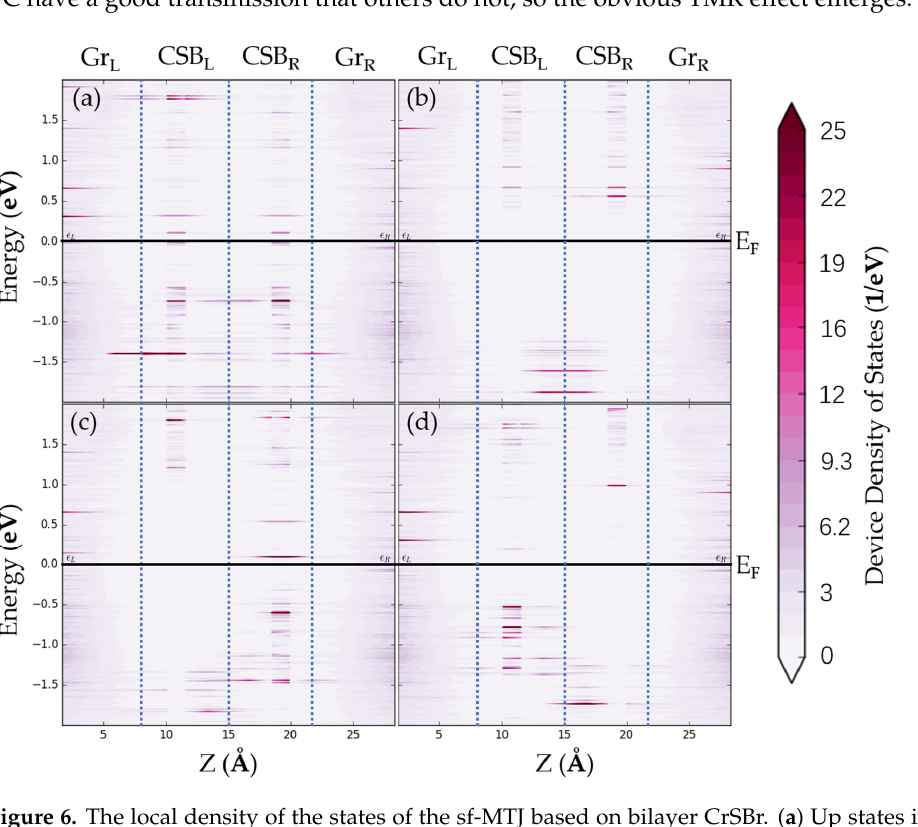
Figure 6. The local density of the states of the sf-MTJ based on bilayer CrSBr. ( a ) Up states in PC; ( b ) Down states in PC; ( c ) Up states in APC; and ( d ) Down states in APC. The vertical axis is the electron energy levels in which the Fermi level is set as 0 eV. The horizontal axis is the position of the device along the transmission direction. Different layers of the device marked above the figure by Gr (cid:2896) (the graphene on the left); CSB (cid:2896) (the left layer of the bilayer CrSBr); CSB (cid:2902) (the right layer of the bilayer CrSBr); and Gr (cid:2902) (the graphene on the left). Red colors indicate a high density of states. The figures are the calculated results of modeling. Subsequently, we will discuss the giant TMR of sf-MTJs with four-layer and six-layer CrSBr. Like the two-layer device, we also obtained the transmission spectra. The trans- mission probabilities of electrons in APC are tiny, leading to negligible (cid:1833) (cid:3002)(cid:3017) . That is one of the factors to the giant TMR values of the two devices (above 10 7 % and 10 5 %). However, the spectra of APC carry little information for the lack of spots with high transmission probability. Therefore, we only provide the transmission spectra of spin-up electrons in PC that have distinct transmission characteristics to illustrate the giant TMRs in Figure 7a,b. Compared with Figure 4a, The transmission characteristics apart from the surround- ing regions of the highest transmission probability in Figure 7a are more indistinctive. To verify the fact that the difference is independent from graphene electrodes, the transmis- sion spectrum of the electrodes is calculated and presented in Figure 7c. The spectrum basically consists of characteristics of Δ (cid:2869) electrons, which are circular around the center. In addition, there is also small transmission at the midpoints of the left and right sides coming from the straining of the graphene when building the heterostructure. The fea- tures of graphene electrodes are relatively obvious in Figure 4a, but not in Figure 7a, meaning that four-layer CrSBr entirely dominates the transmission. The eigenstates of the highest transmissions in the red circles can be seen in Figure 7d, similarly with Figure 4e.